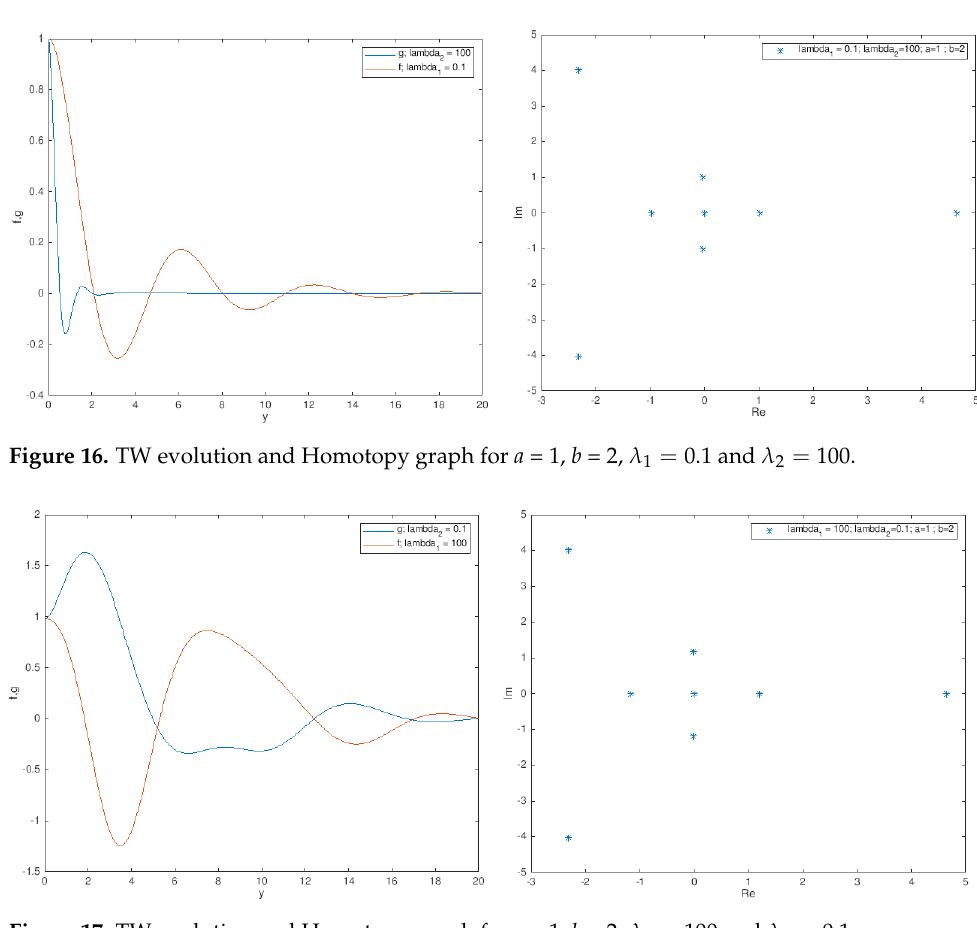
Figure 17. TW evolution and Homotopy graph for a = 1, b = 2, λ 1 = 100 and λ 2 =